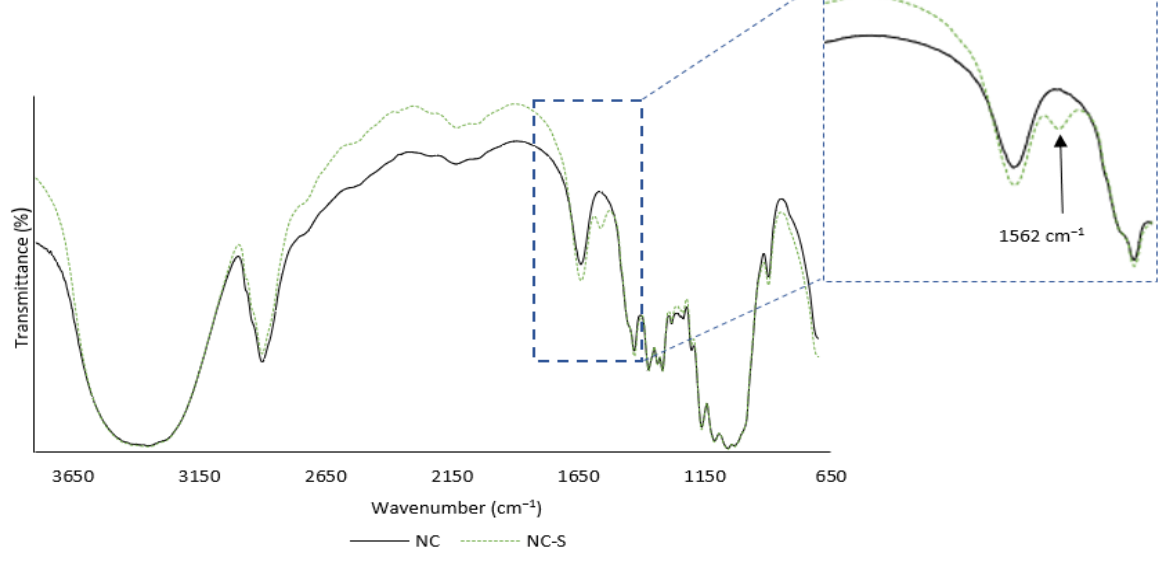
Figure 4. The FTIR spectra of non-modified and APTES-modified nanocellulose.